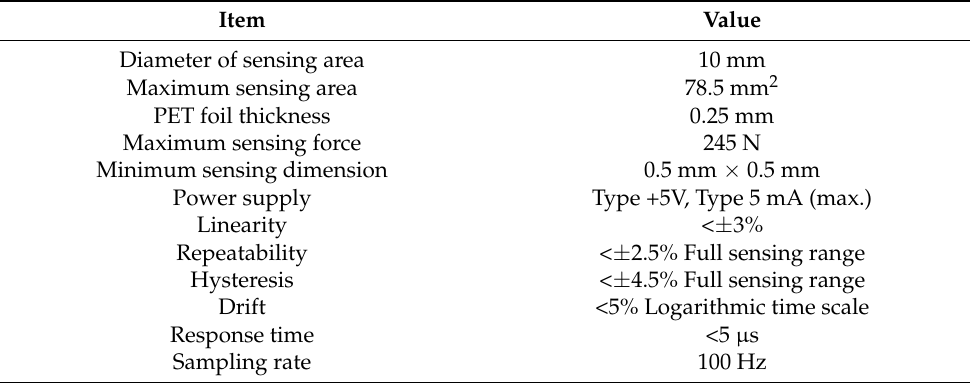
Table 4. The specification of the force sensor device.